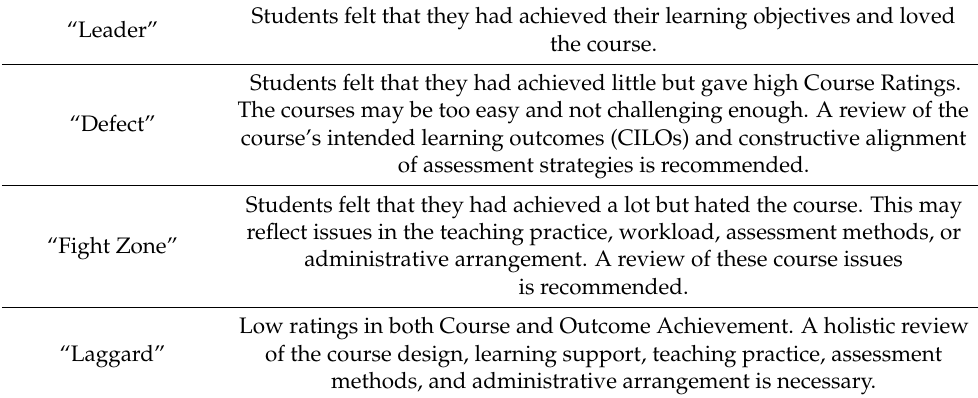
Table 4. The definition of Outcome Achievement–Course Rating